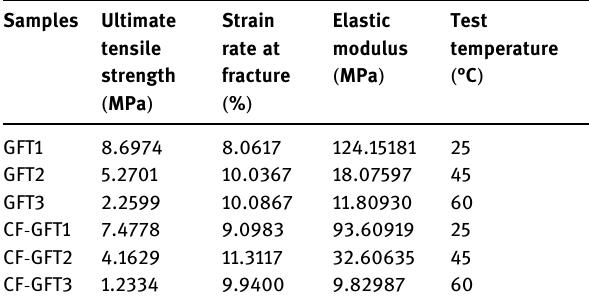
Table 2: Tensile properties of 2D braided composite test